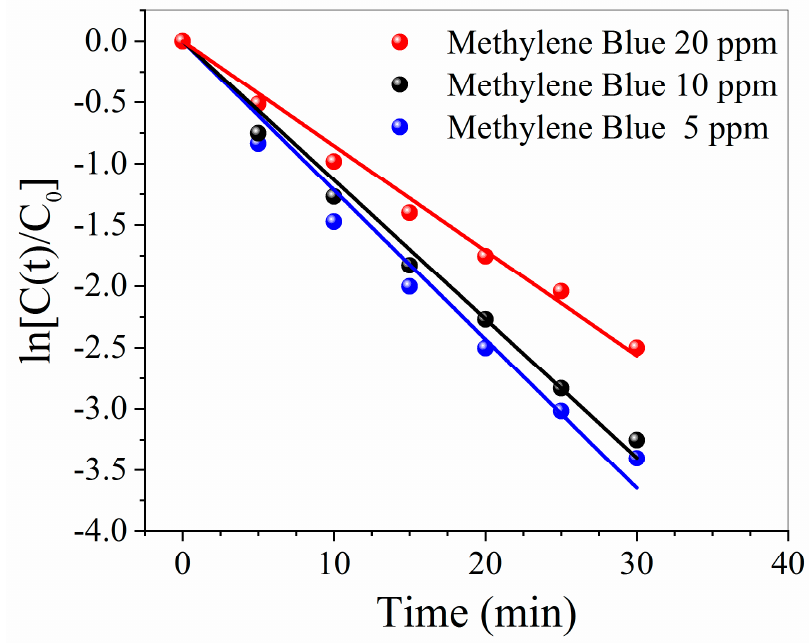
Figure 8. Effect of initial concentrations of Methylene Blue (5, 10, and 20 ppm) on the reaction rate.